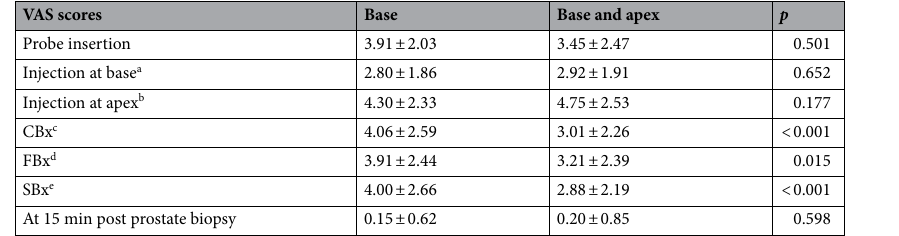
Table 2. Mean VAS scores during prostate biopsy in patients according to the site of the PNB. Data are expressed as mean ± SD. a Mean and SD of VAS scores during prostate base injections. b Mean and SD of VAS scores during prostate apex injections. c Mean and SD of VAS scores for individual CBx. d Mean and SD of VAS scores for individual FBx. e Mean and SD of VAS scores for individual SBx. CBx magnetic resonance